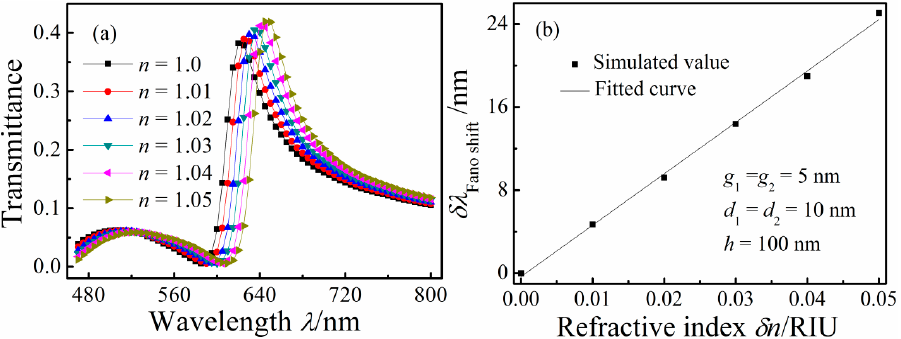
Figure 3. Steady state magnetic field H z distributions for the ( a ) transmission dip (580 nm); and Figure 4. ( a ) Transmission spectra for different refractive index n ; and ( b ) the shift of the Fano resonance peak as a function of the refractive index change δ n .